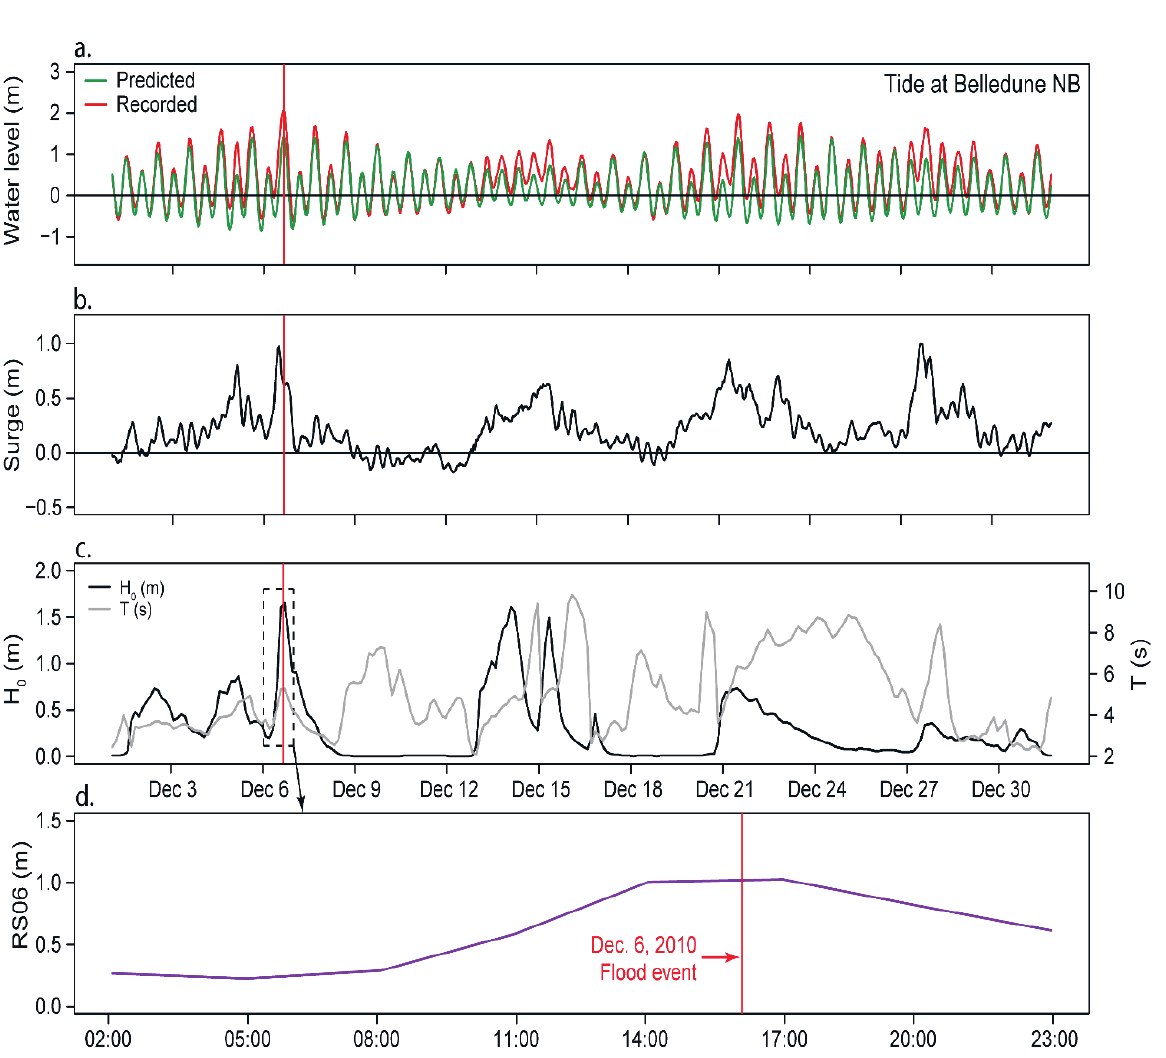
Figure 7. Tidal and hydrodynamic data on 6 December 2010. ( a ) Represents predicted and observed tide (m) at Belledune tide gauge and ( b ) The residual surge (m). The storm surge occurred during high waves reaching 1.63 m ( c ). ( c,d ) show the flooding event on 6 December, where a 1.02 m wave runup was estimated at 4:00 p.m. local time (8:00 p.m.